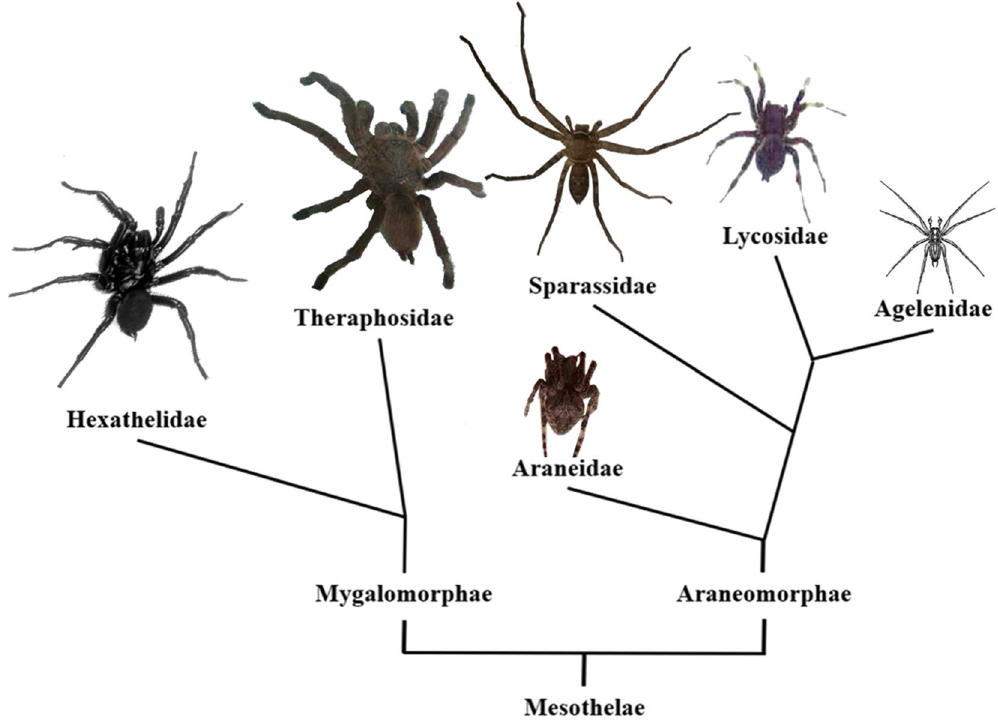
Figure 1. Simplified phylogenetic tree of spider families with the physique in the relative size of the representative species of each family. Modified from Kuhn-Nentwig et al. (2011) 11 . Hadronyche versuta 15 in Hexathelidae, Chilobraechys guangxiensis in Theraphosidae, Araneus trifolium in Araneidae, Heteropoda venatoria in Sparassidae, Lycosa singoriensis 16 in Lycosidae, and Agelenopsis potteri 17 in Agelenidae are mentioned in the present